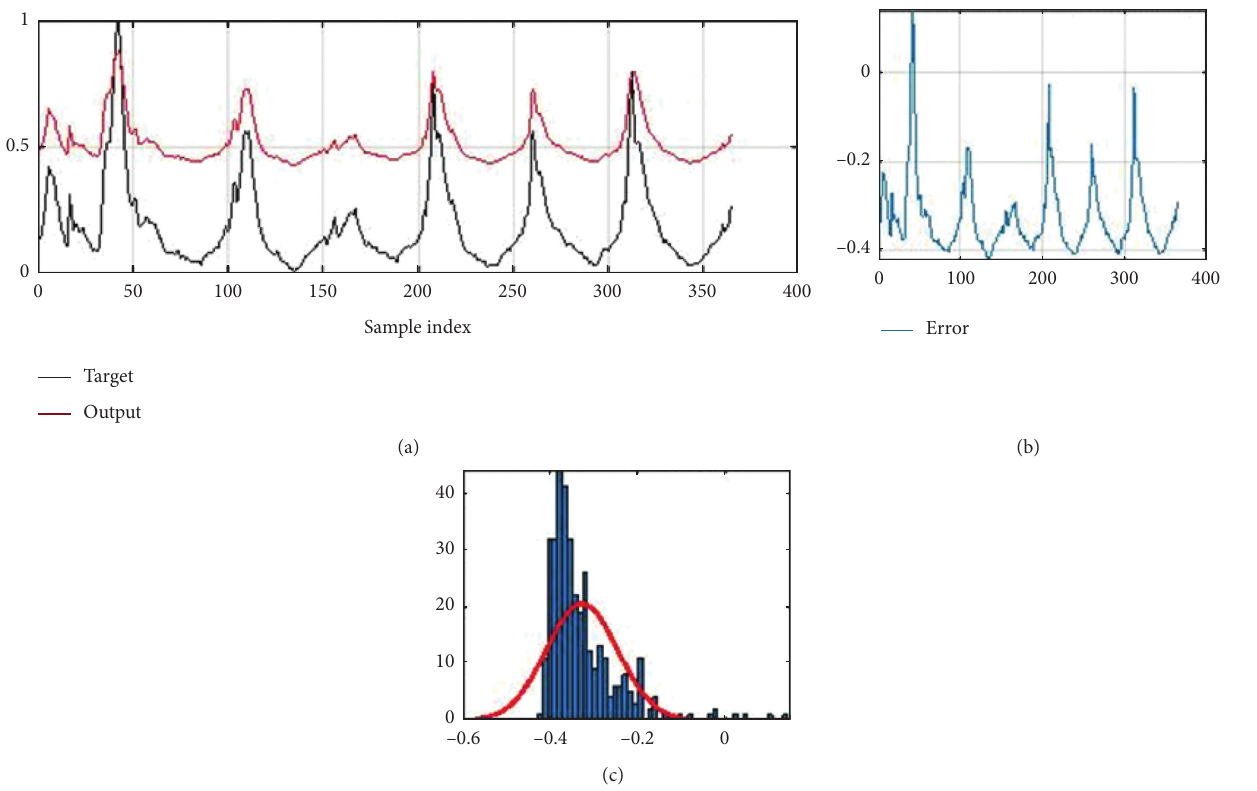
Figure 10: Performance of the SVMR model. (a) Train data. (b) MSE � 0.11444, RMSE � 0.33829, and MAE � 3.8887. (c) Error St. D. � 0.081002.